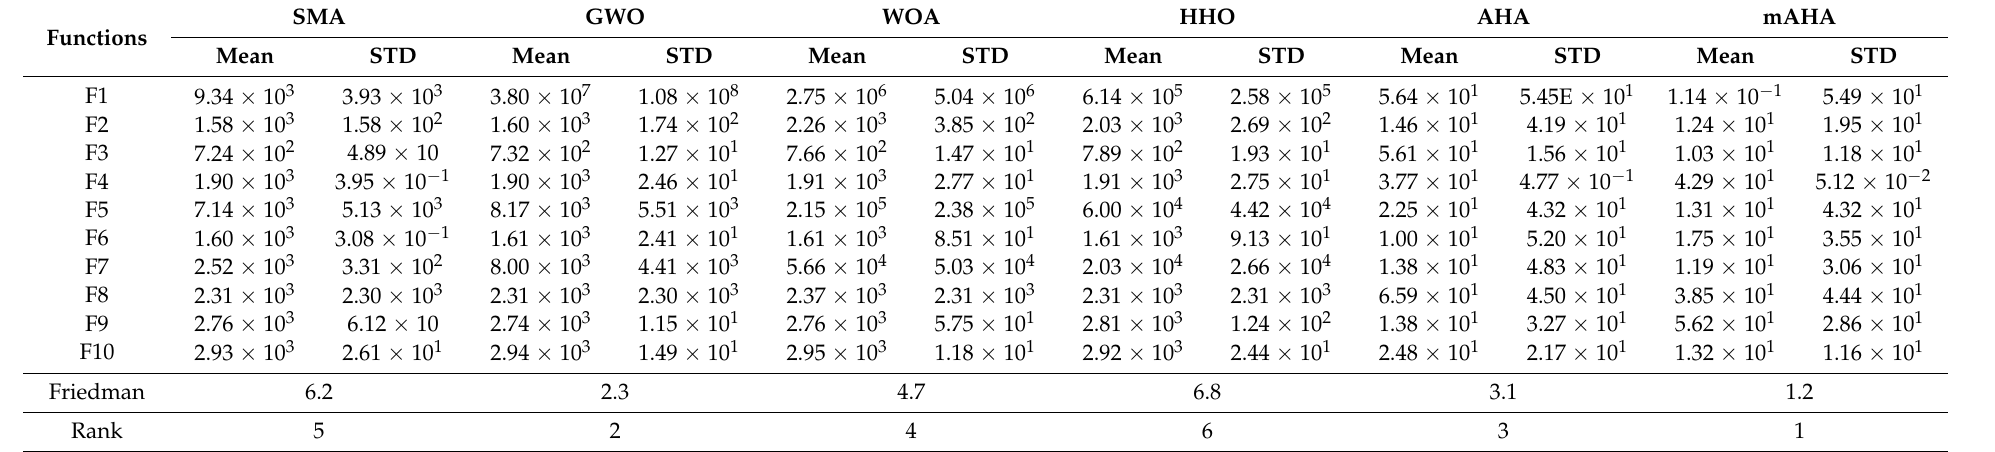
Table 1. The statistical results on the CEC’20 test suite that have been obtained by the proposed mAHA and the competitor algorithms for 30 runs with Dim 10.